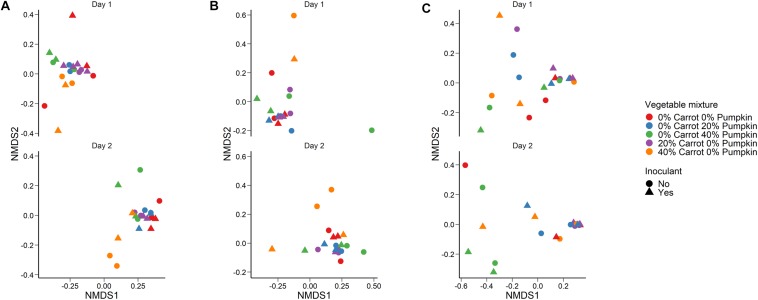
Non-metric dimensional scaling (NMDS) plot of the Bray–Curtis dissimilarities for the (A) bacterial microbiota in sorghum silage (Stress = 0.12), (B) fungal microbiota (Stress = 0.13) in sorghum silage, and (C) aerobic stability after 14 days aerobic exposure (Stress = 0.14) by vegetable mixture, sampling day, and use of an inoculant.